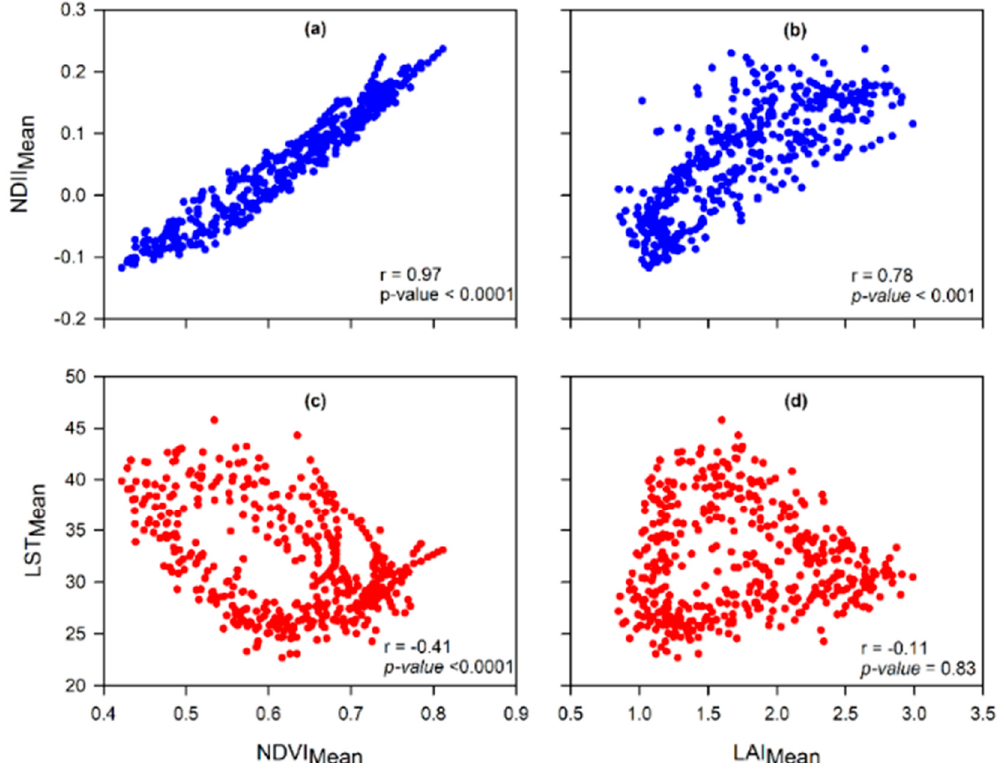
Figure 5. Correlation of mean values for the 8-day NDVI Mean and LAI Mean with NDII Mean ( a,b ), as well as with LST Mean ( c,d ) at the annual scale. The NDVI Mean shows stronger correlation with canopy water content (i.e., NDII) and canopy temperature (i.e., LST) compared to the LAI Mean when used as proxies for canopy cover. LST Mean shows hysteresis with NDVI Mean and LAI Mean while NDII Mean shows hysteresis with LAI Mean .